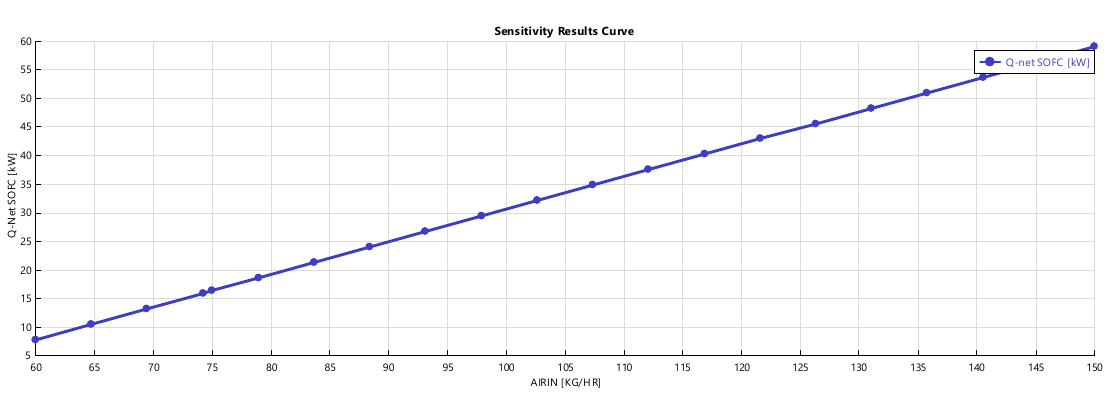
Figure 10. Influence of the air flow rate to the cathode on SOFC power production.